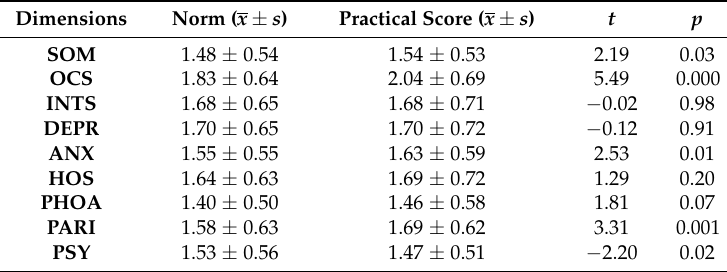
Table 2. Respondents’ scores in dimensions of SCL-90-R ( n =